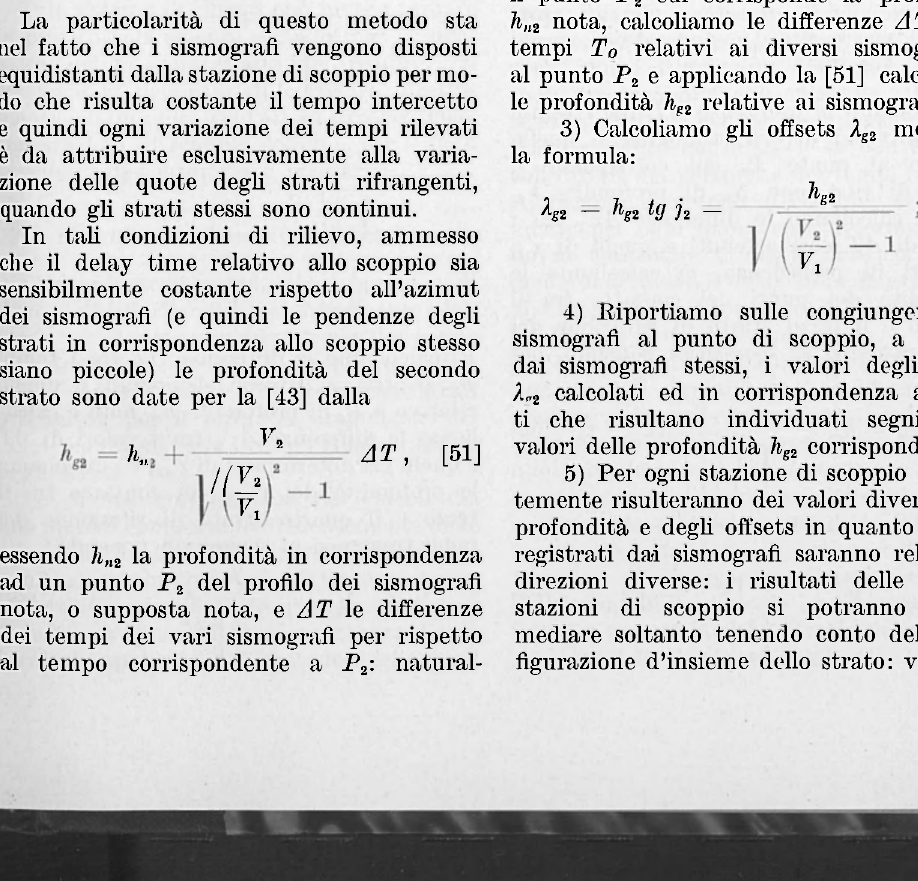
figurazione d'insieme dello strato: